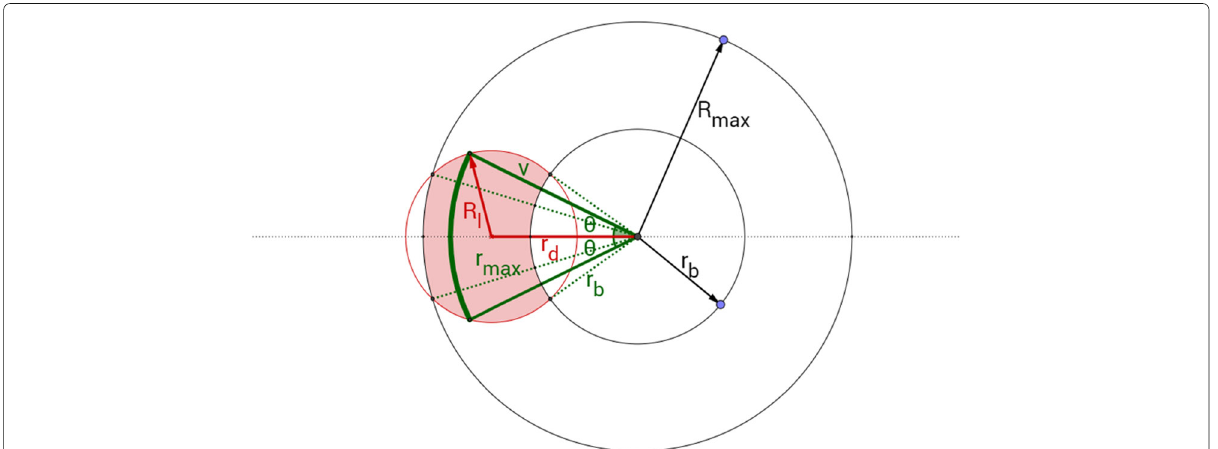
Fig. 4 Calculation of area limited by the circle of radius R l , service area circle, and broadcast area circle